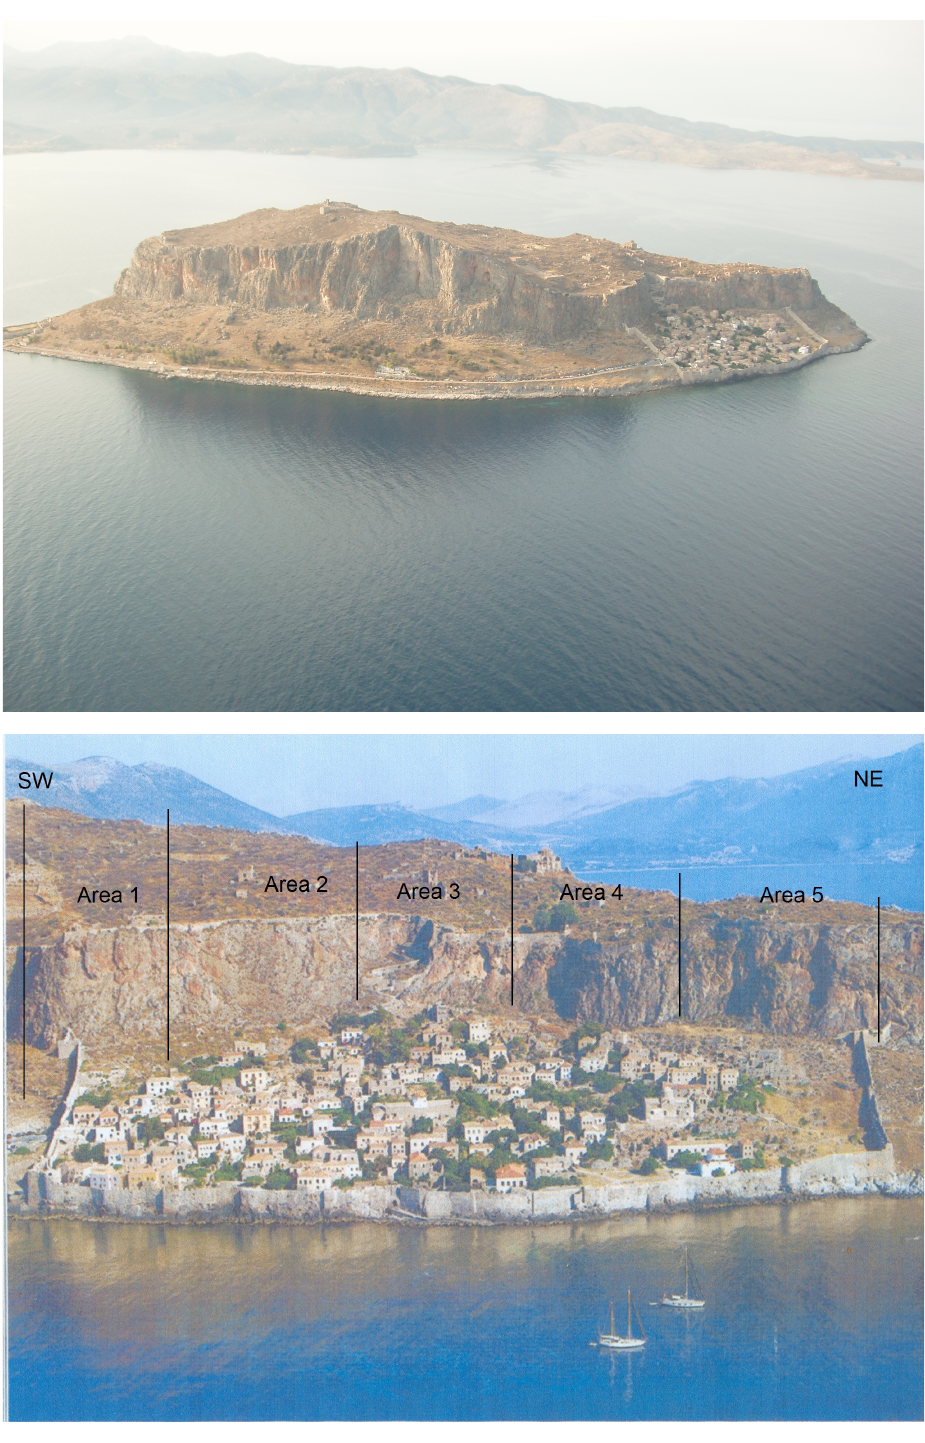
Fig. 1. (a) Panoramic view of the rock promontory, (b) close view of Monemvasia historical site.